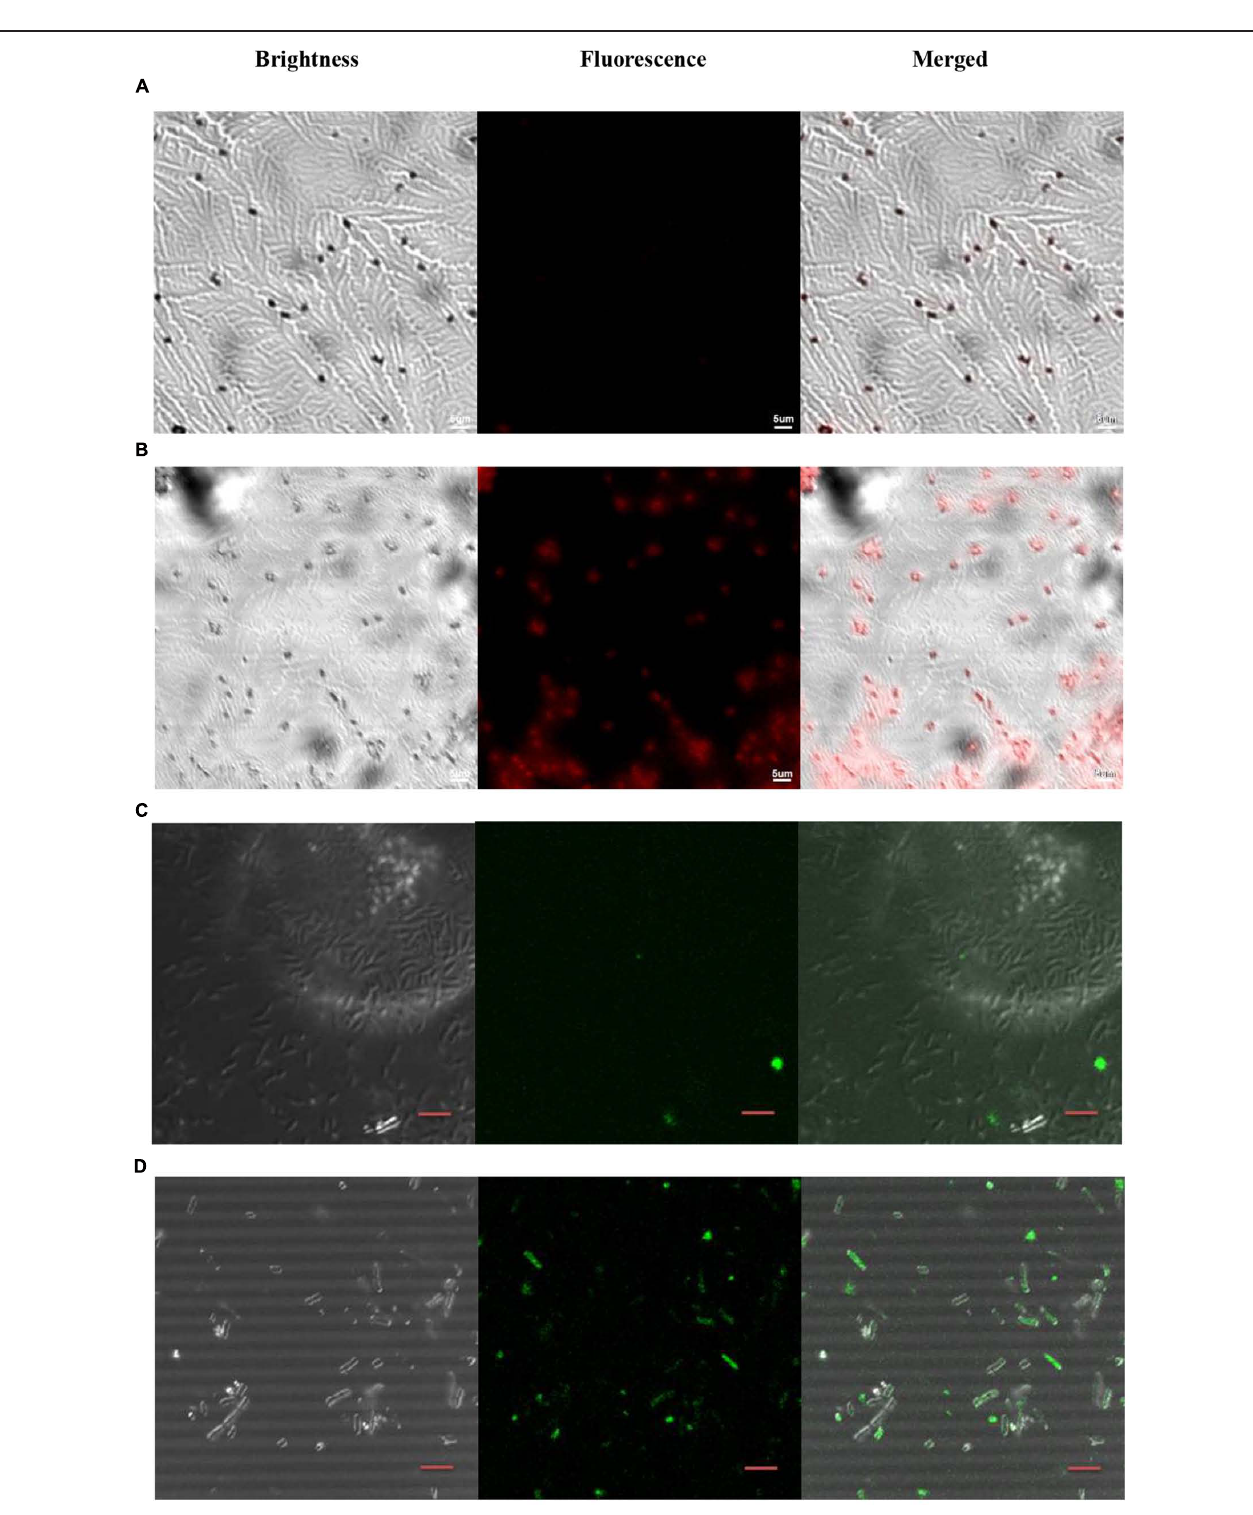
FIGURE 4 | Ts-QDs605 and Ts-LPs-CM selectively targeting Klebsiella pneumoniae cells. The cell-targeting of Ts to K. pneumoniae ATCC 700603 observed by confocal laser scanning microscopy (CLSM) using quantum dots (QD) or coumarin (CM)-loaded liposomes (LPs): (A) QDs605. (B) Ts-QDs605. (C) LPs-CM. (D) Ts-LPs-CM. K. pneumonia ATCC 700603 cells (approximately 1 × 10 5 bacteria/ml) were first incubated with Ts-QDs605 (10 nM) for 2 h at 37 ◦ C followed by trice rinse with PBS, and then placed on slides. A solution containing 4% (wt/vol) paraformaldehyde was added for sample fixation for 30 min. Ts-LPs-CM were used at 20 nM but different from Ts-QDs605 assay, the cells receiving Ts-LPs-CM were sent to CLSM without washing with PBS. The bar indicated scale of 5 µ m.